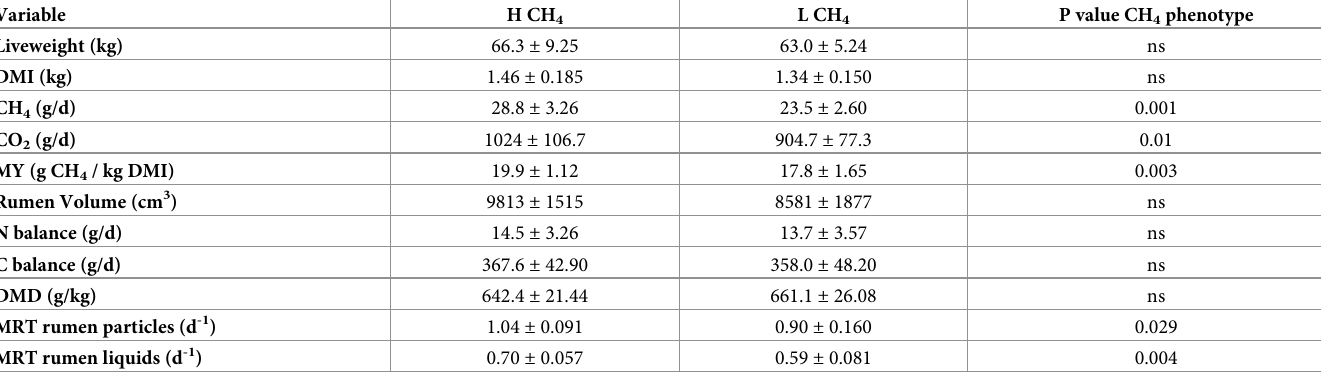
Table 1. Descriptive statistics (mean ± standard deviation of the mean) for phenotypic traits related to CH 4 emission in high (H) or low (L) emitting sheep; live- weight (kg), dry matter intake (DMI), daily CH 4 (g/d), CO 2 (g/d), methane yield (MY), rumen volume (cm 3 ), nitrogen (N) balance (g/d), carbon (C) balance (g/d), dry matter digestibility (DMD; g/kg), mean retention time (MRT) rumen particles and MRT liquids (/d). P values represent statistical differences in the variables related to the high (H; n = 10) and low (L; n = 10) CH 4